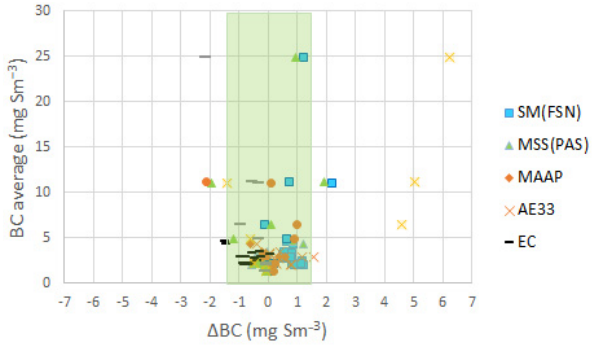
Figure 3. The difference in the BC results in relation to average BC for MSD engines in laboratories and on-board ships; 90th percentile of ∆ BC ( ± 1.5 mg Sm − 3 ) is highlighted by green box. The standard deviation between results obtained with SM(FSN), MSS(PAS), LII 300, MAAP, and EC(TOA) increased in absolute terms as BC concentrations increased (Figure 4a). Aethalometers that showed the highest ∆ BC results were not included in this analysis. In relative terms, the standard deviation was 5–15% for engine-out exhaust and, at a wide range of BC, concentrations were up to almost 30 mg Sm − 3 (except aethalometers). After the SOx scrubber, and in some cases after SCR, deviation in relative terms was high (15–35%) due to the low BC concentration level (<5 mg Sm − 3 ), although deviation in absolute terms was only <0.8 mg Sm − 3 . For engine-out exhaust at the same BC concentration level, deviation was even lower in absolute terms (<0.4 mg Sm − 3 ). For the HSD engine, the deviation of the BC results was higher when Ar-20 fuel was used than when aromatic- free Ar-0 fuel was used, and the aromatic content of fuel influenced the BC results and comparability between instruments.